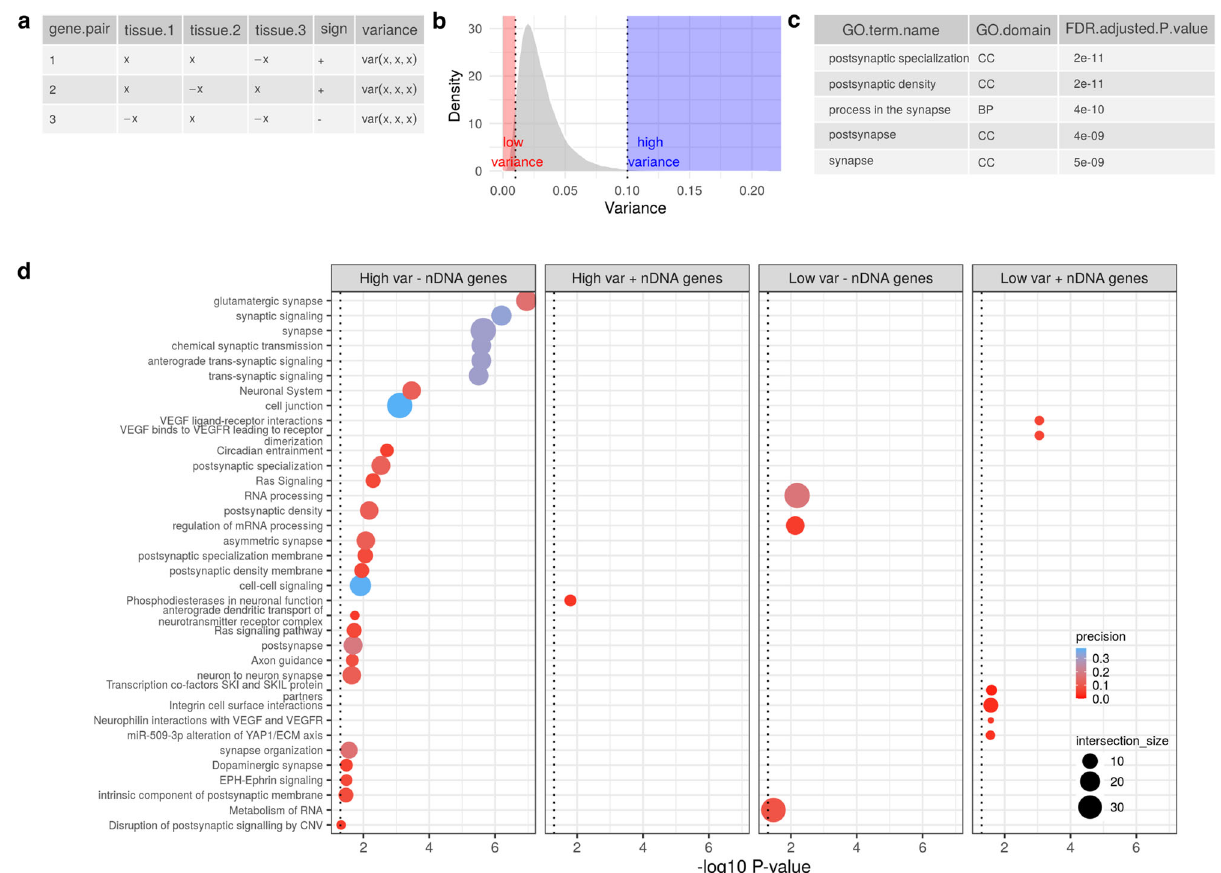
Fig. 3 Visualisation of cross-CNS gene pair variances in GTEx data and the processes enriched in four variance-de fi ned gene sets. a Schematic to visualise generation of cross-CNS variances. For each mitochondrial − nuclear gene pair, a variance is taken of its per-tissue Spearman ’ s ρ values. The pair is assigned a directionality (sign) based on the majority directionality of its ρ values. b . Density plot of the distribution of cross-CNS mitochondrial − nuclear gene pair variances. The left-hand dotted line enclosing the shaded red area is the cut-off for ‘ low variance ’ gene pairs, the right-hand dotted line enclosing the blue shaded area is the cut-off for ‘ high variance ’ gene pairs. c SynGO (synaptic gene ontology) output showing the top fi ve enrichments for the high variance negative nuclear gene set. P values are FDR-adjusted. d gPro fi ler2-derived enrichments for four nuclear gene sets: high variance negative, high variance positive, low variance negative and low variance positive. The dotted line indicates a 5% signi fi cance cut-off. P values were corrected using the gPro fi ler g:SCS method, optimised for enrichment analysis P value